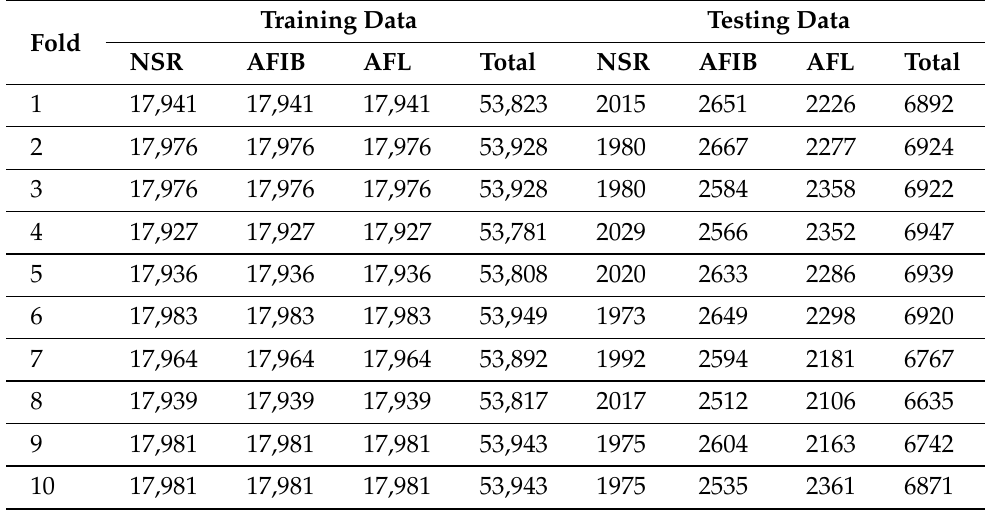
Table 4. The number of data vectors used for training and testing during 10-fold cross-validation.